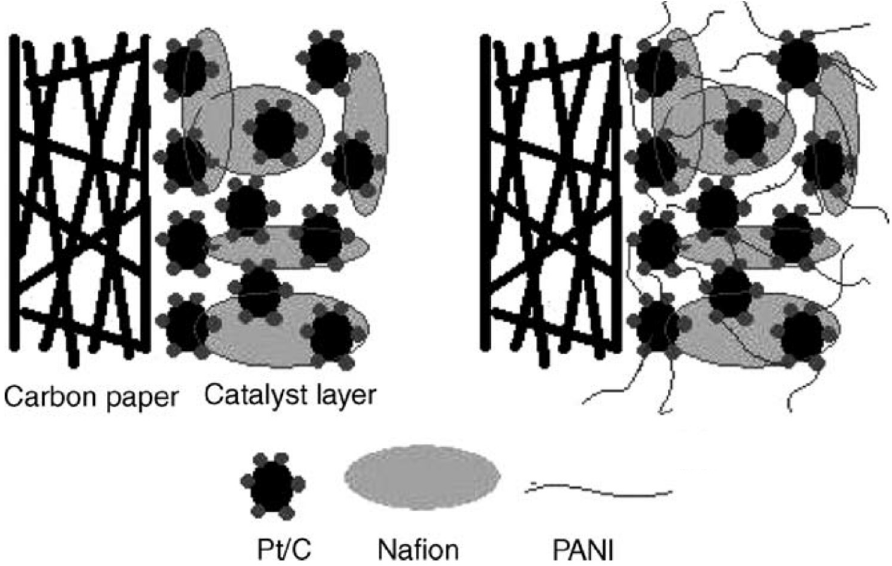
Figure 22. Schematic representation of the role of PANI nanofibers in connecting the catalyst particles embedded in the Nafion matrix. Reprinted with permission from Ref. [191]. Copyright 2006 Elsevier.